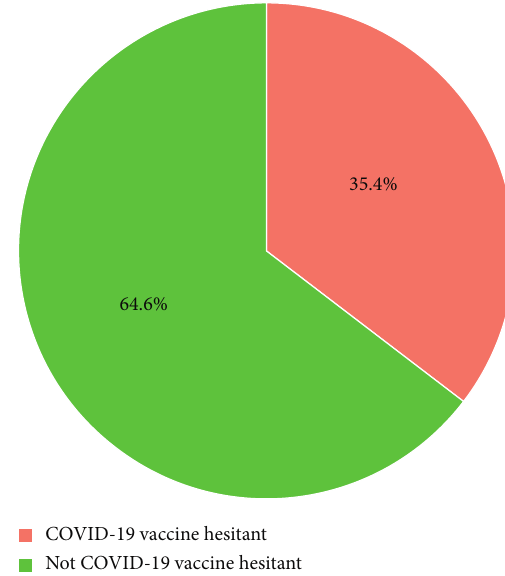
Figure 1: Prevalence of COVID-19 vaccine hesitancy among HCWs in Imo State,